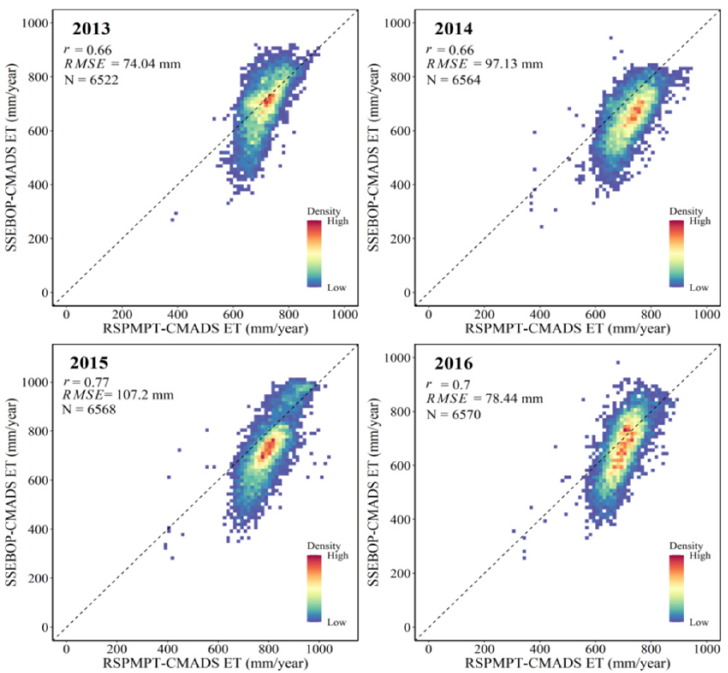
Figure 5. Density scatter plots of the RSPMPT-CMADS and SSEBop-CMADS estimated annual evapotranspiration from 2013 to 2016.